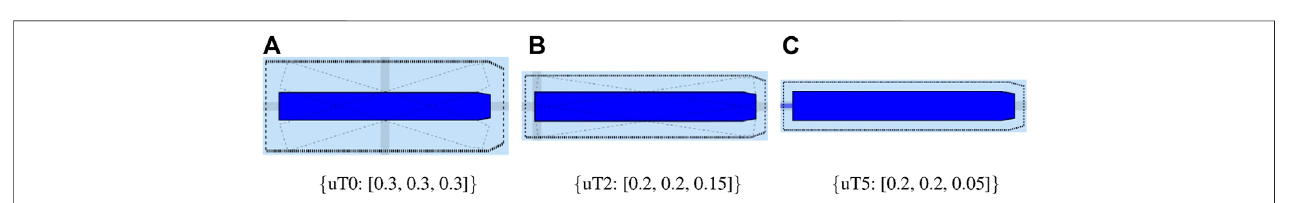
FIGURE 8 | Dynamic behaviour of the axiomatic SD0 for the different time steps and associated uncertainties.